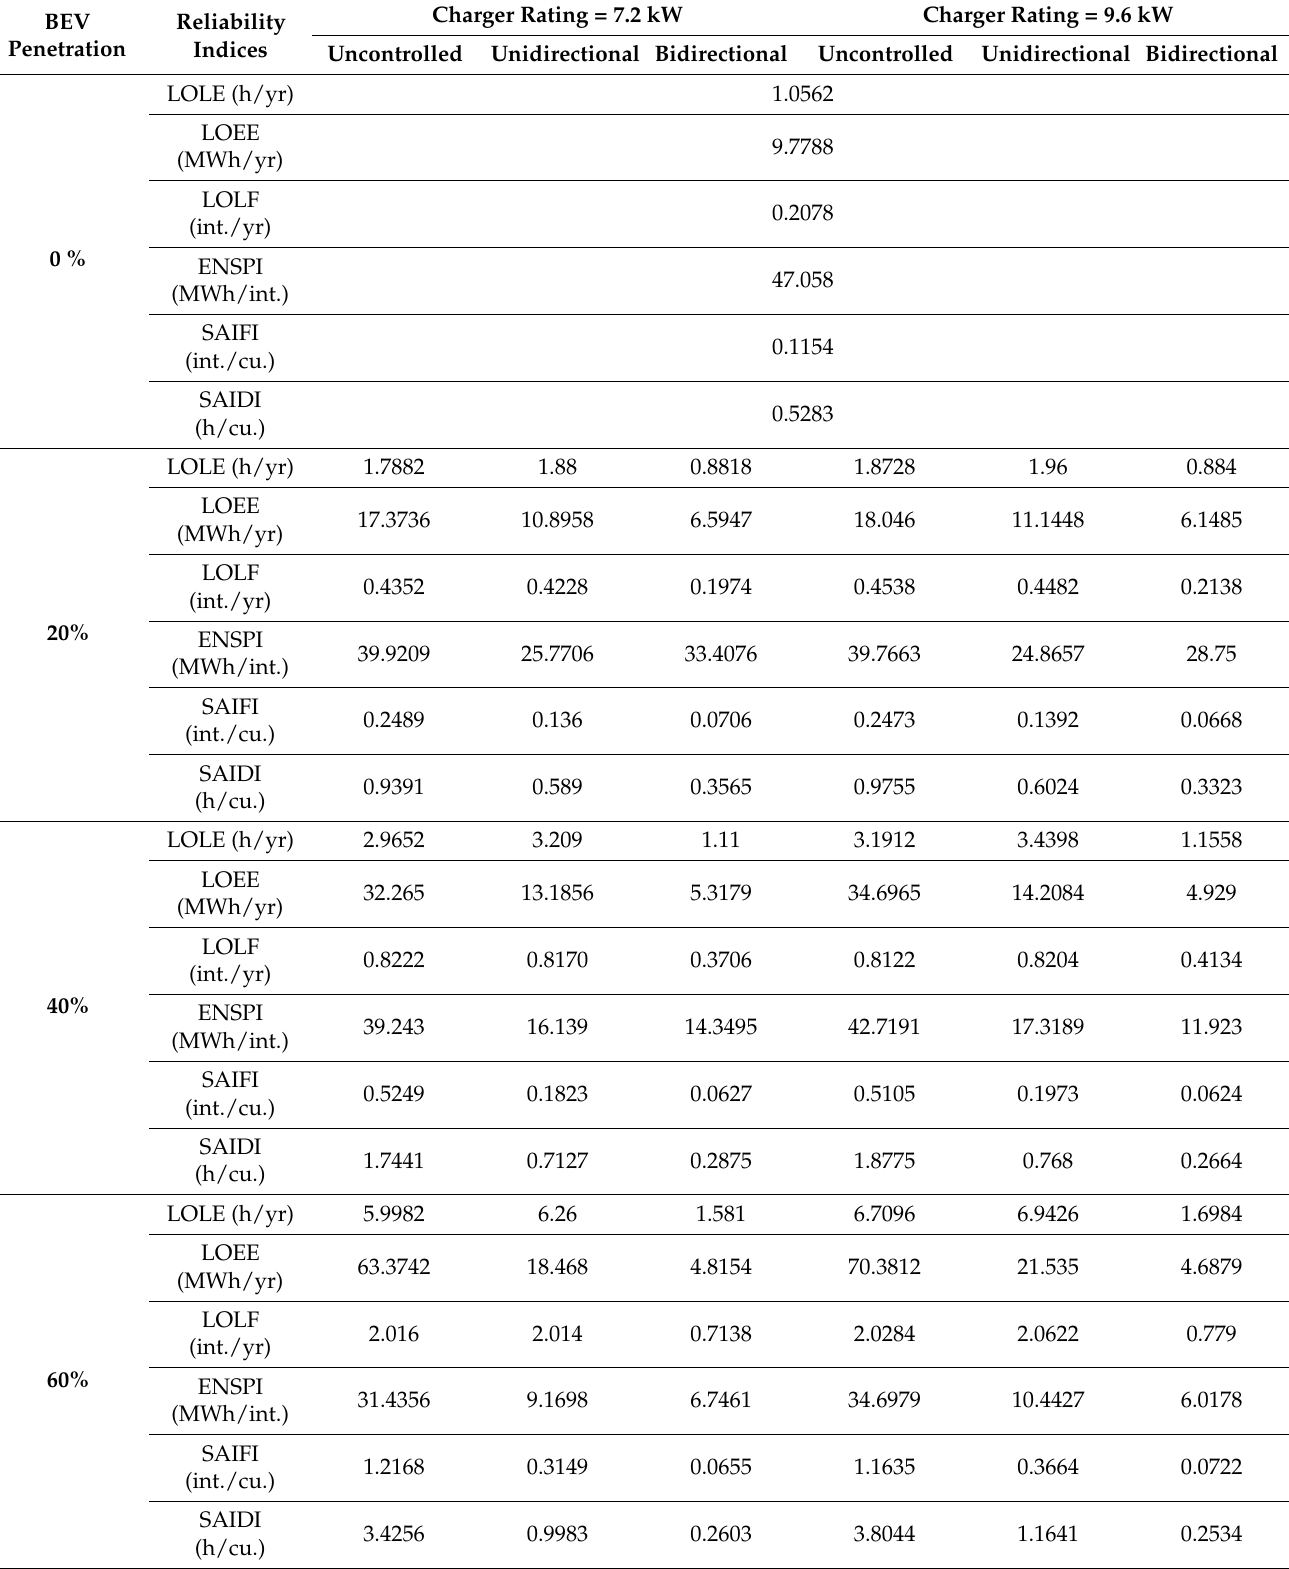
Table 3. Reliability indices for different BEV penetrations and different chargers’